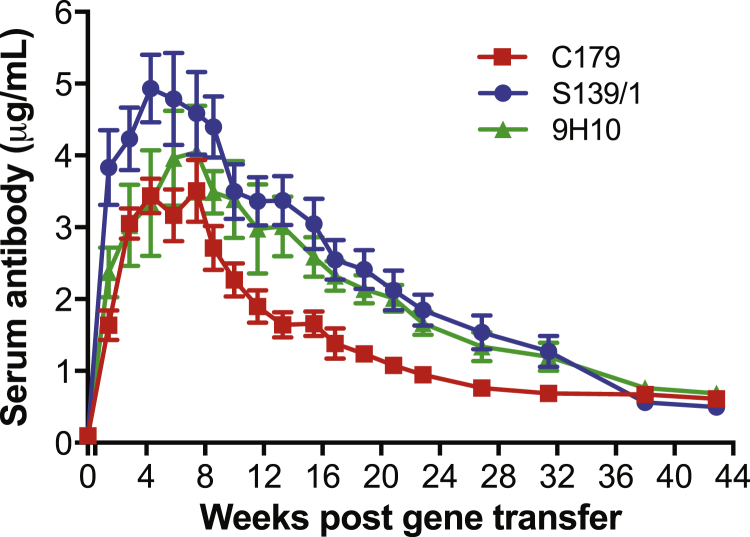
Optimized pDNA/EP Regimen Yields Durable Oligoclonal mAb Response in MiceBALB/c mice (n = 8) were pretreated with 20 U of hyaluronidase and administered 10 μg of H/L gWiz pDNA encoding each C179, S139/1, and 9H10 at distinct sites followed by EP. Serum mAb concentrations were measured by HA-specific binding ELISAs. All data are presented as mean ± SEM.